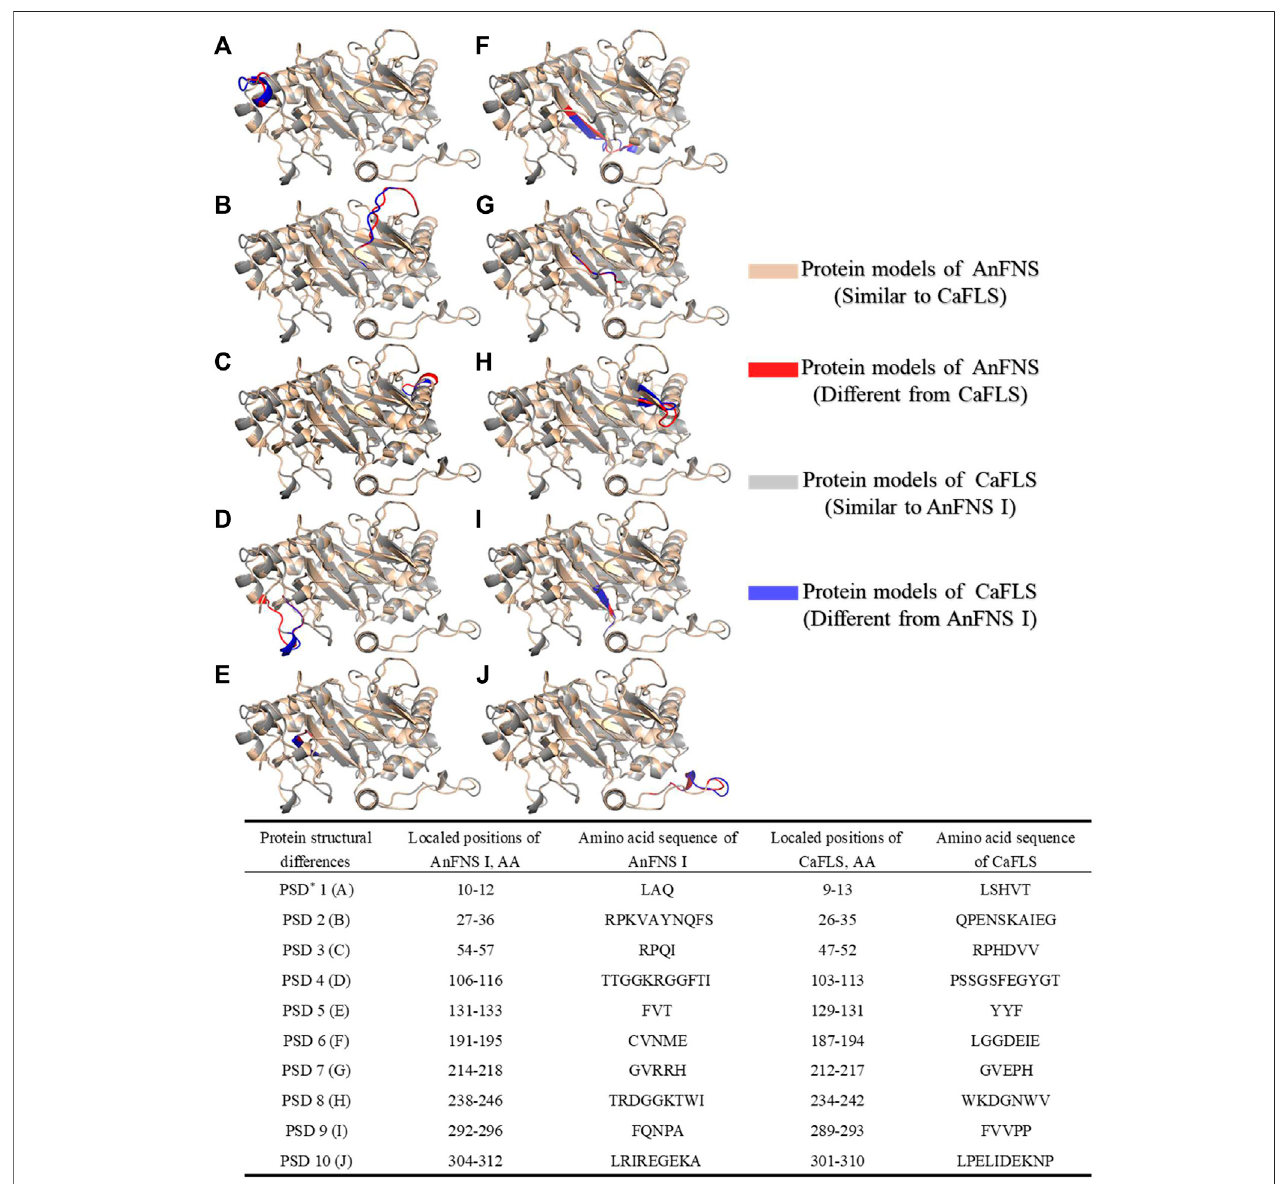
FIGURE3| MajorstructuraldifferencesbetweenAnFNSIandCaFLS.Note: (A) Proteinstructuraldifferences1(PSD1). (B) Proteinstructuraldifferences2(PSD2). (C) Protein structural differences 3 (PSD 3). (D) Protein structural differences 4 (PSD 4). (E) Protein structural differences 5 (PSD 5). (F) Protein structural differences 6 (PSD 6). (G) Protein structural differences 7 (PSD 7). (H) Protein structural differences 8 (PSD 8). (I) Protein structural differences 9 (PSD 9). (J) Protein structural differences10(PSD10)(Theportionsoftheproteinmodelswithsigni fi cantstructuraldifferencesaredisplayedindifferentcolors.Brownandredshowthestructure ofwild-type CaFLS. Gray and blueshow thestructure ofwild-type AnFNS I.Also red and blueindicatesthe portion ofthe wild-type CaFLSthatdifferedsigni fi cantlyfrom AnFNS I).